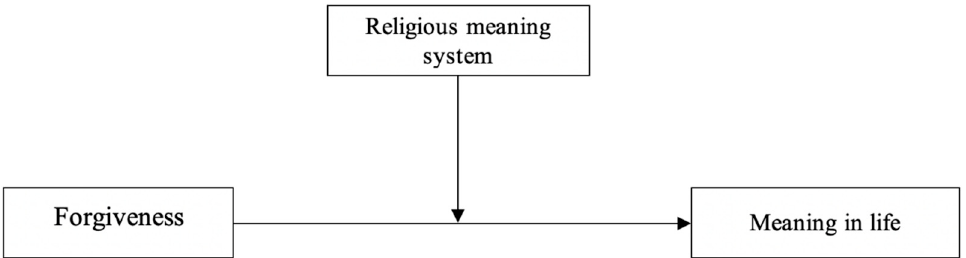
Figure 2. A conceptual model of the moderating role of the religious meaning system in the rela- tionship between forgiveness and meaning in life.